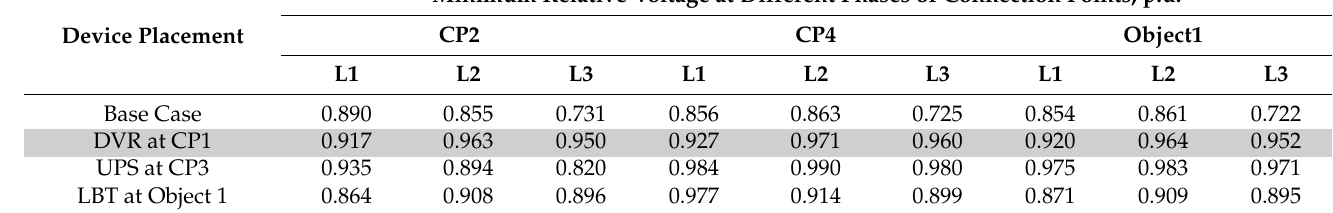
Table 5. Comparison of solutions for Object 1.